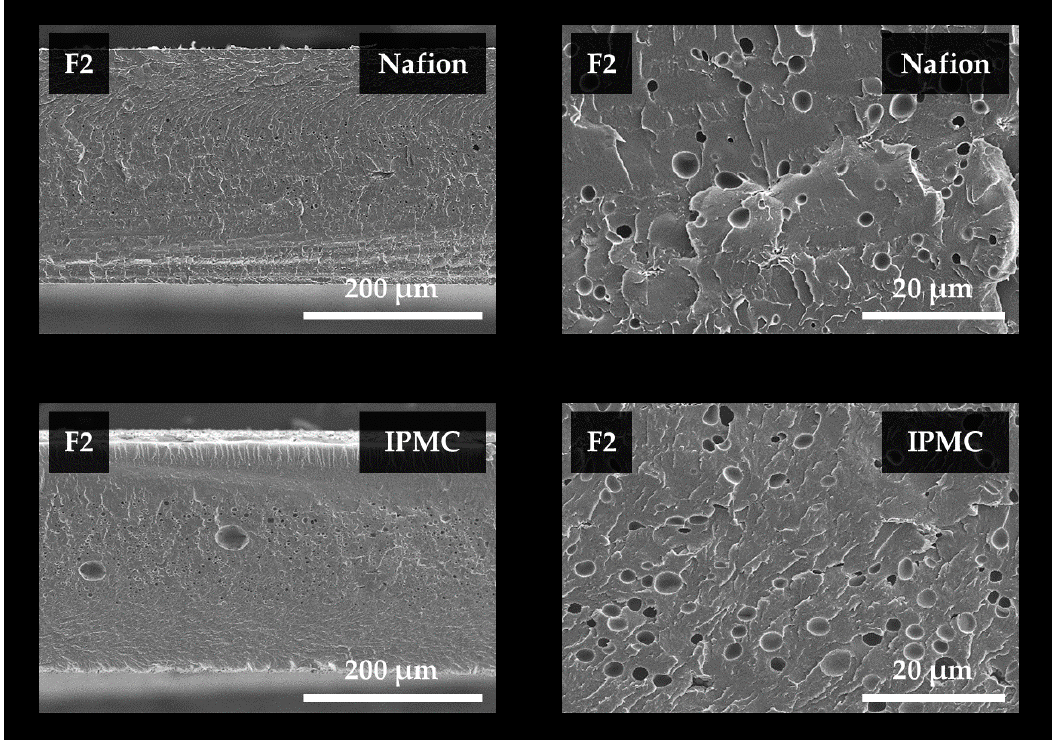
Figure 10. Scanning electron microscope observation image of the cross section of Nafion and IPMC specimens, according to the F2 foaming condition.